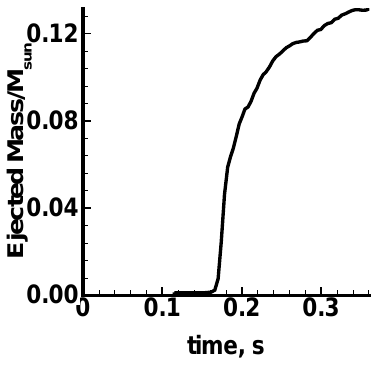
Figure 4: Time dependence of the ejected mass dur- ing the magnetorotational explosion with initial dipole magnetic field, from [22].